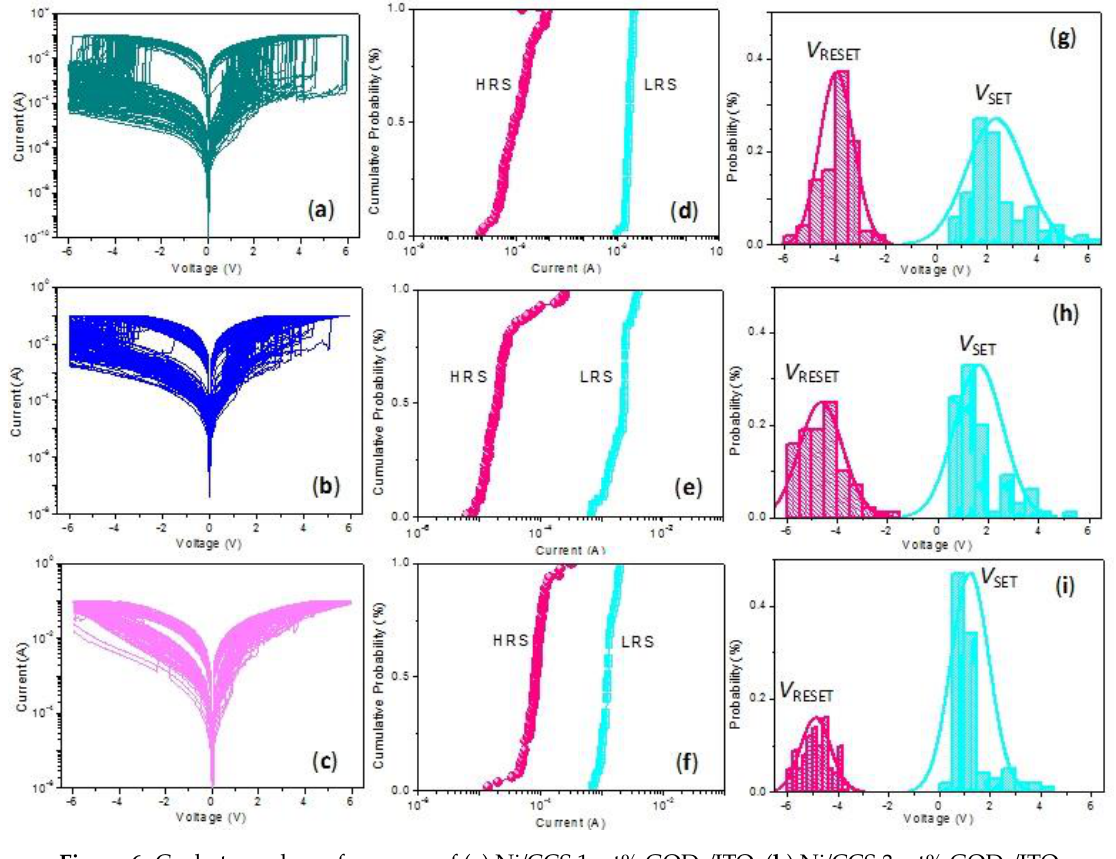
Figure 6. Cycle-to-cycle performance of ( a ) Ni / CCS:1 wt% GQDs / ITO, ( b ) Ni / CCS:3 wt% GQDs / ITO and ( c ) Ni / CCS:5 wt% GQDs / ITO during 100 continuous cycles for binary data storage applications. In detail, ( d – f ) show cumulative analyses for the current distribution in the low and high-resistance states (LRS and HRS) during cycle-to-cycle operation. ( g – i ) are SET and RESET voltage ( V SET and V RESET ) distributions for 100 cycles, presented as histograms. Table 3. Data profiles concerning the mean and standard deviations ( I mean and I std ).